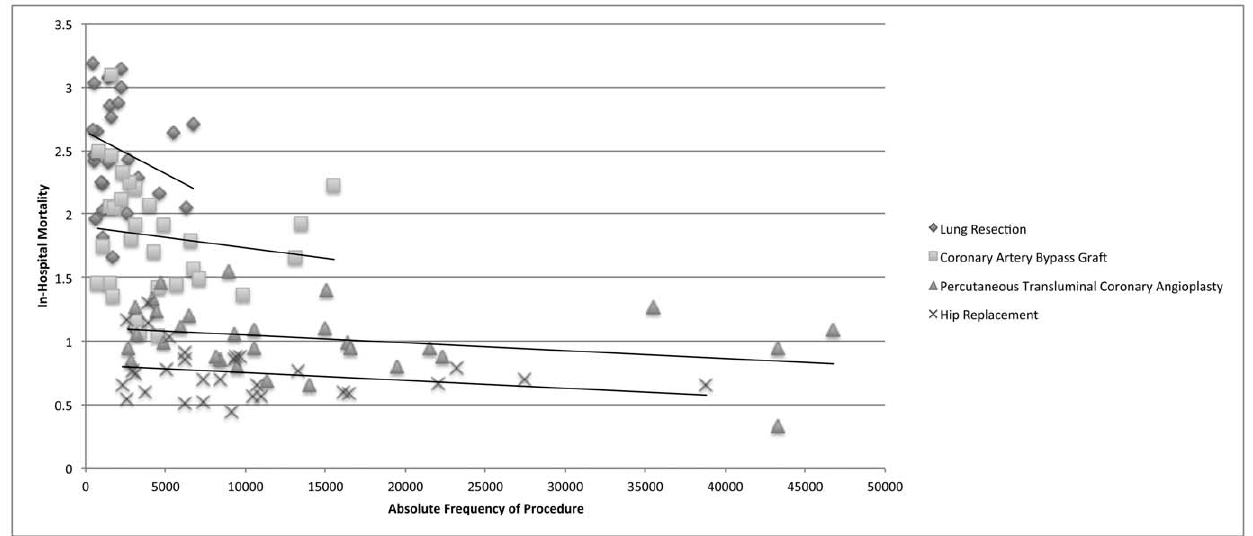
Figure 1. In-hospital morality decreases with increasing absolute frequency of a procedure. doi:10.1371/journal.pone.0046314.g001 PLOS ONE |